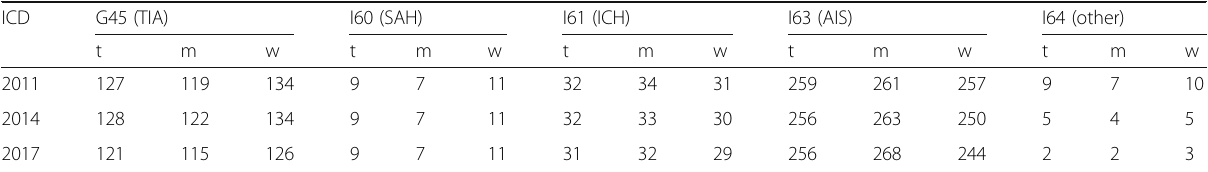
ICD, international classification of diseases; TIA, transient ischemic attack; SAH, subarachnoid hemorrhage; ICH, intracranial hemorrhage; AIS, acute ischemic stroke; t, total; m, male; f,